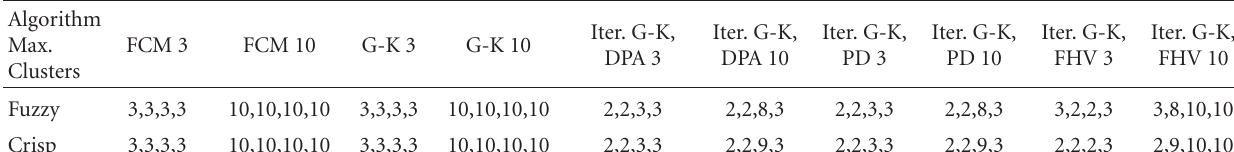
Table 6: Number of resultant clusters using three algorithms and three performance measures with respect to maximum number of clusters Algorithm